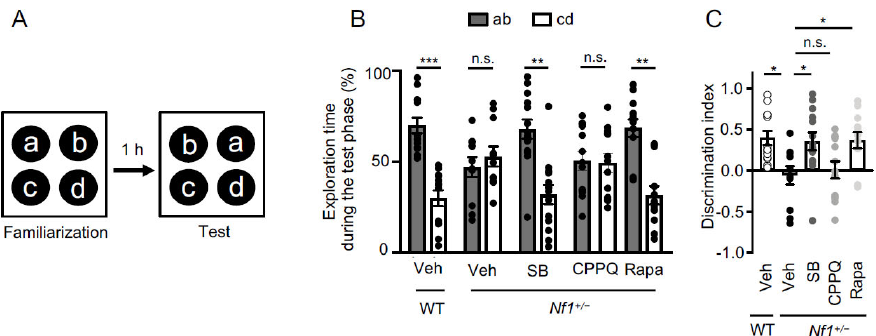
Figure 3. Impact of 5-HT 6 receptor-operated mTOR signaling upon associative memory in Nf1 +/ − mice. Injections of vehicle, SB258585 (SB, 2.5 mg/kg, i.p.), CPPQ (2.5 mg/kg, i.p.) or rapamycin (Rapa, 10 mg/kg, i.p.) were performed 30 min before